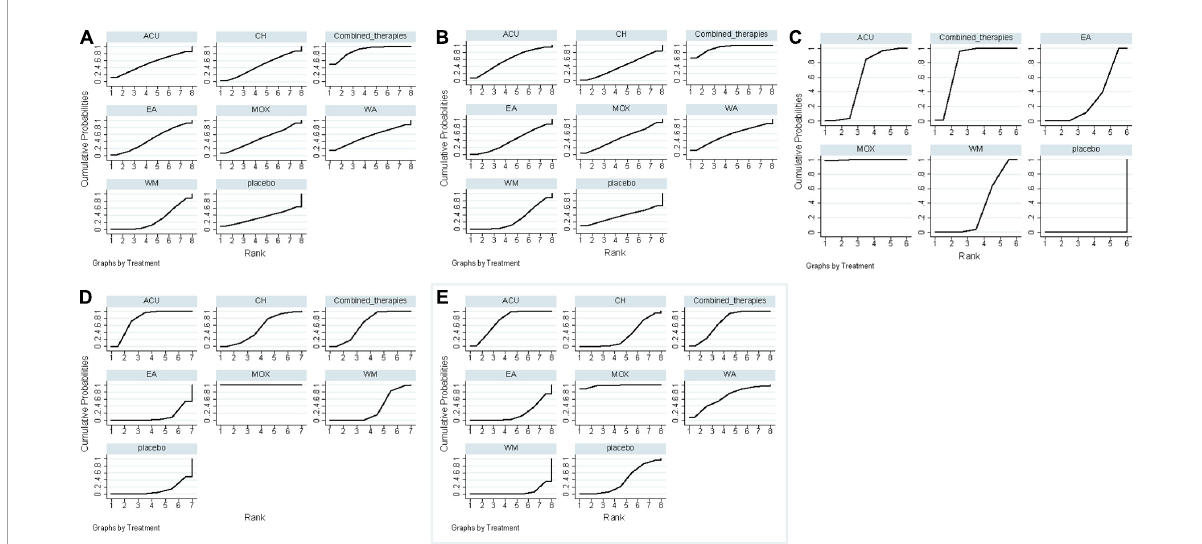
FIGURE5 Surface under the cumulative ranking curves. (A) SAS scores; (B) SDS scores; (C) HAMA scores; (D) HAMD scores; (E) response rate. ACU, acupuncture; EA, electroacupuncture; MOX, moxibustion; CH, Chinese herb medicine; WA, warm acupuncture; combined therapies, the combination of acupuncture-related therapies and other therapies; WM, western medicine of anti-diarrheal or anti-spasmodic; placebo, and placebo acupuncture/blank